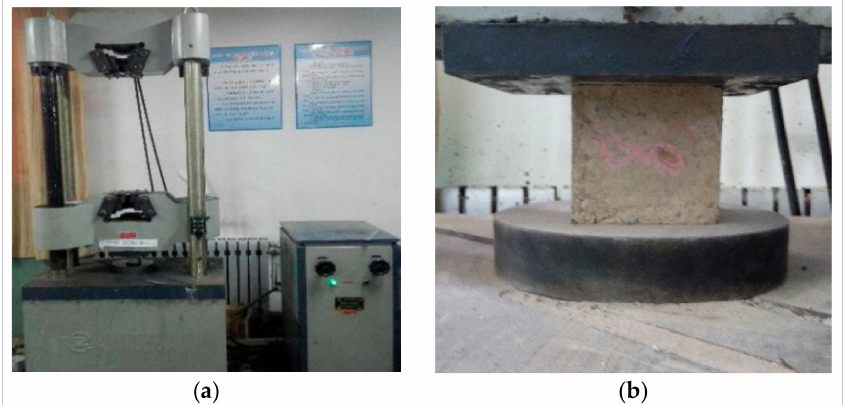
Figure 6. Test equipment: ( a ) WES-1000B electro-hydraulic servo universal testing machine and ( b ) a specimen under compression.